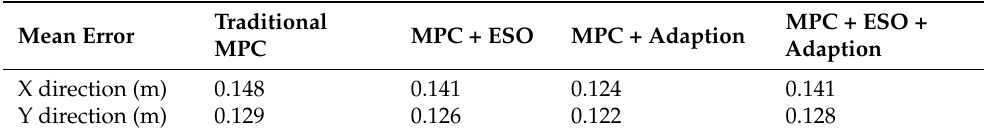
Table 2. The average errors of the whole process with 0.1 m/s disturbance velocities in both the X and Y directions.